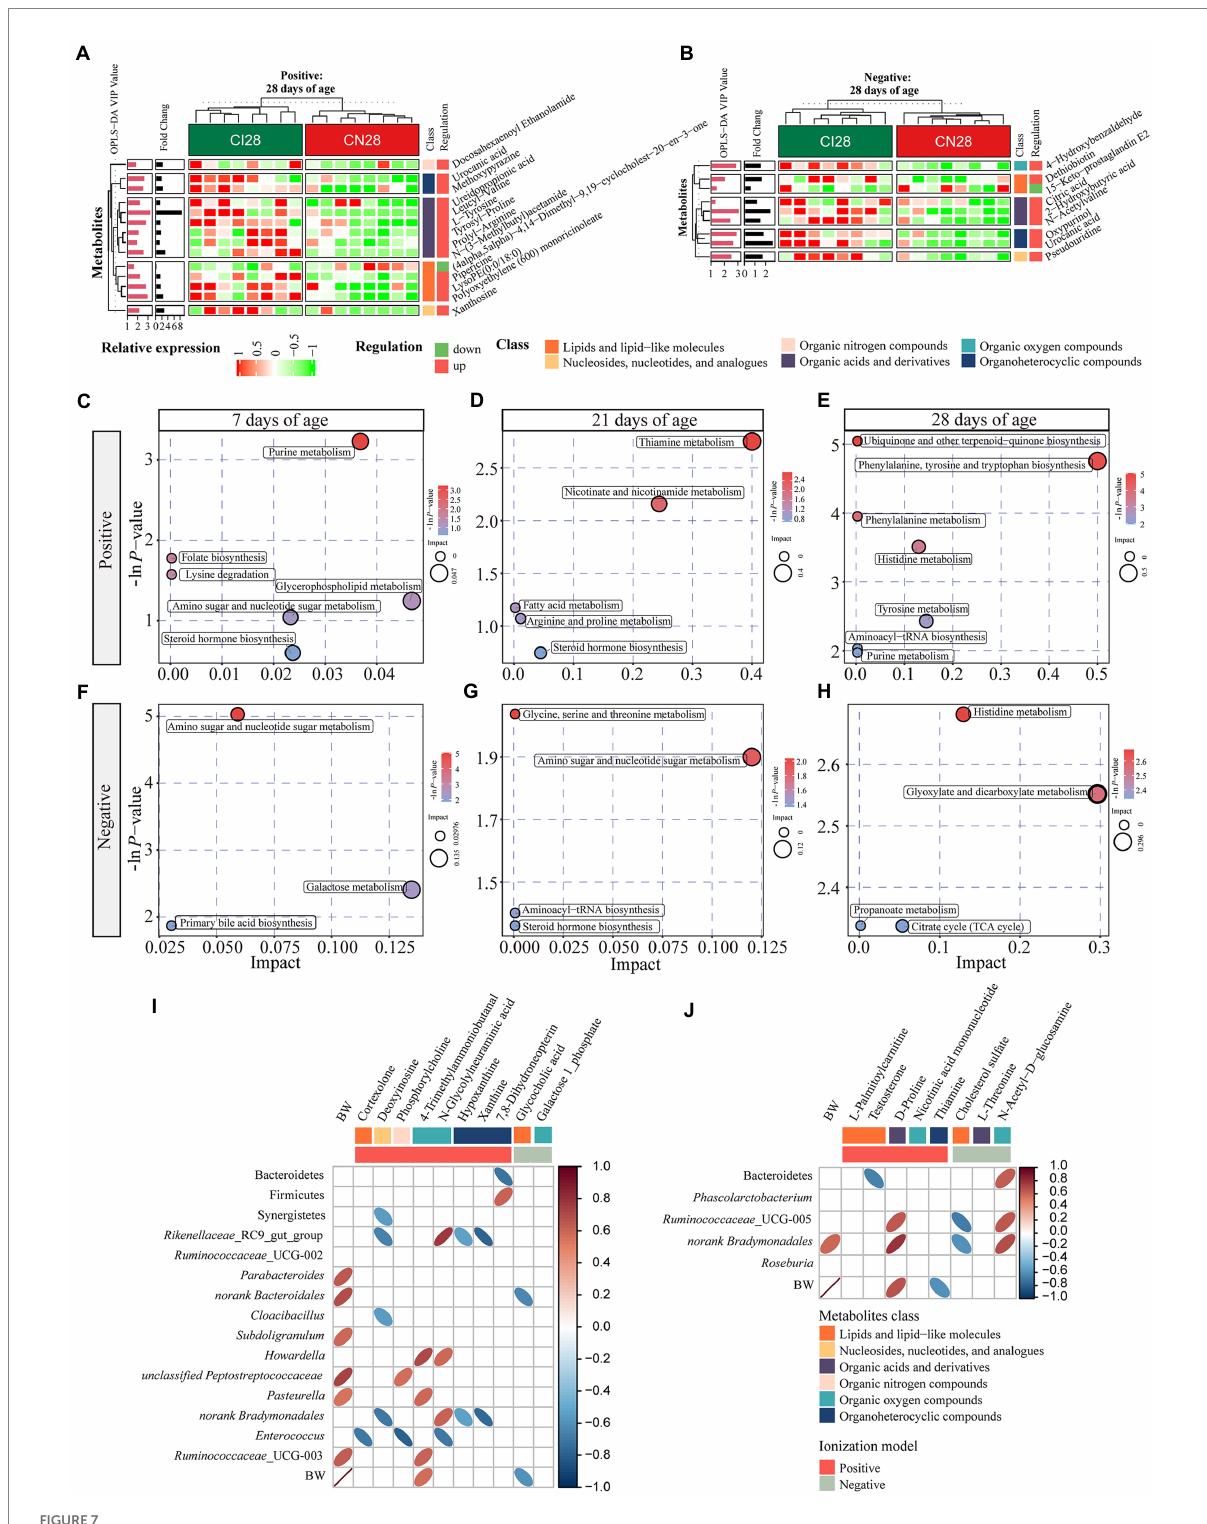
FIGURE 7 (A,B) Hierarchical clustering analysis for different metabolites with MS2 based on the non-target metabolomics of the colonic contents between the intrauterine growth restriction (IUGR) and normal birth weight (NBW) piglets at 28 days of age ( n = 8; Positive: A , Negative: B ). The relative metabolite level is depicted according to the color scale. Red indicates significant up-regulation ( p < 0.05), and green indicates significant down-regulation ( p < 0.05). (C–H) Metabolome view map of significant metabolic pathways characterized in the colonic contents between the IUGR and NBW piglets at 7, 21, and 28 days of age (Positive: (C–E) , Negative: (F–H) ). Significantly changed pathways based on enrichment and topology analysis are shown. The x-axis represents pathway impact, and the y-axis represents pathway enrichment. Large size and red colors represent major pathway enrichment and high pathway impact values, respectively. (I,J) Spearman’s rank correlations between colonic microbiota and metabolites at 7 (I) and 21 (J) days of age. Ellipses in the graph represent significant correlations, red represents significant positive ( p < 0.05) correlations, and blue represents significant negative ( p < 0.05)